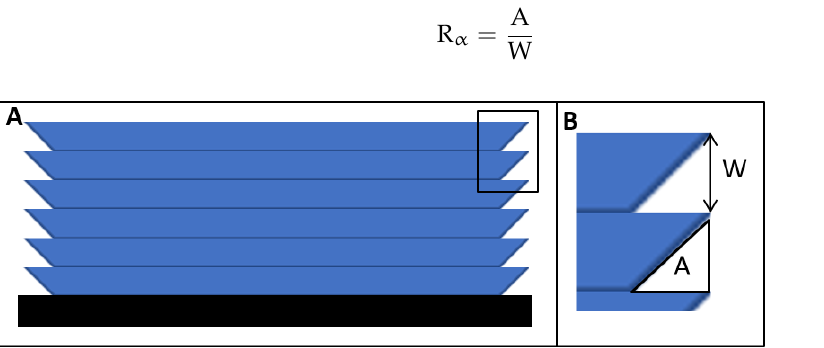
Figure 3. ( A ) Example of a 3D printed part and its sidewall roughness. ( B ) Zoom from 3 ( A ) where the thickness of the layer (W), and the uncured area in every layer (A) are described.